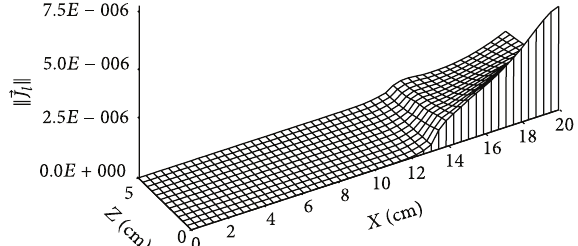
Figure 6: Moisture content distributions after 62 days.